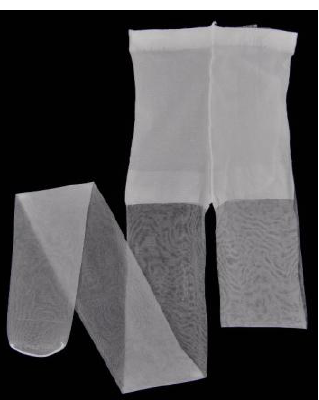
Figure 1. Panty stocking